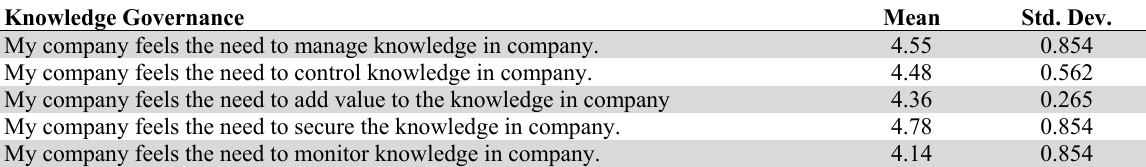
Mean and Standard Deviation for “Knowledge Governance” Knowledge